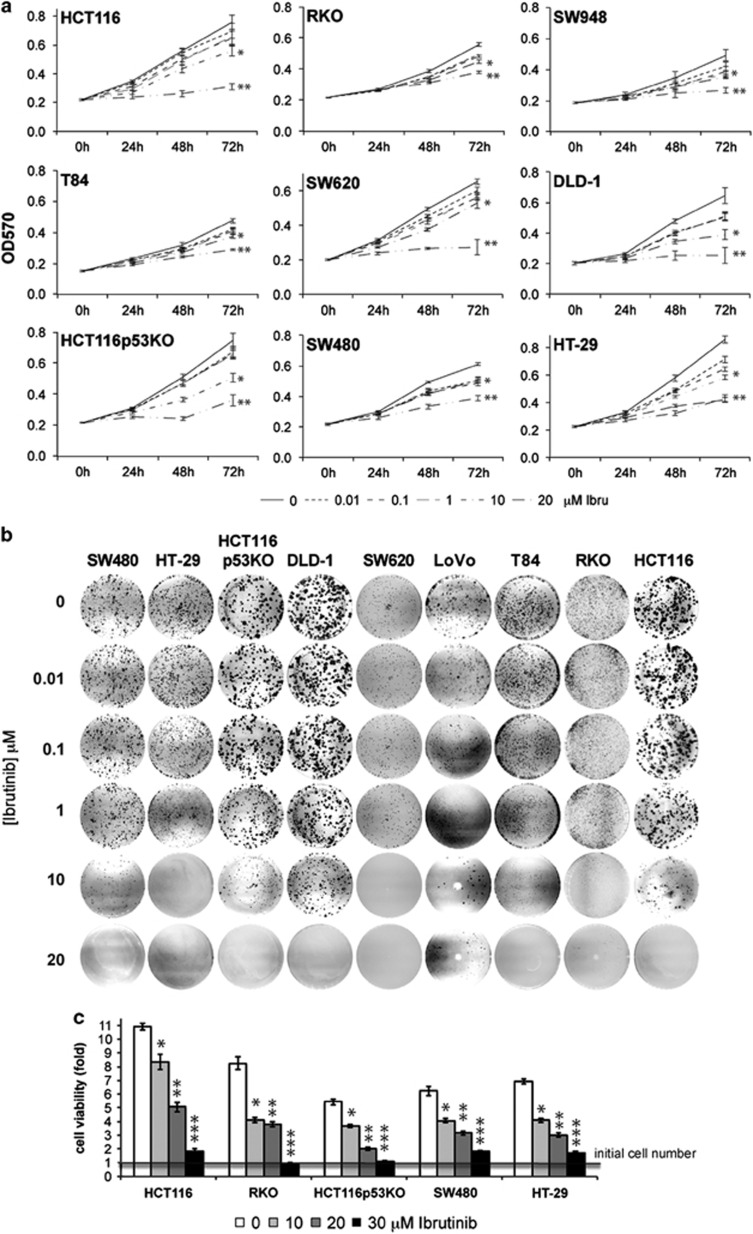
p65BTK inhibition affects growth and survival of colon cancer cells. (a) Time course showing Ibrutinib dose response (0, 0.01, 0.1, 1, 10, 20 μM Ibru) of colon carcinoma cell lines characterized by different genetic background; cell proliferation was determined every 24 h by MTT assay on cells incubated with Ibrutinib at the indicated concentrations; error bars show s.e.m.; data are the average of 3–5 independent experiments. Ibrutinib at 10 and 20 μM significatively decreases cell growth in all cell lines *10 vs 0 μM Ibru P<0.05; **20 vs 0 μM Ibru: P<0.05. (b) Clonogenicity was assessed by seeding cells at low density and incubating them with the indicated doses of Ibrutinib for 10–12 days, at the end of which colonies were stained by crystal violet. (c) Cell viability was assessed after 72 h of treatment with the indicated concentration of Ibrutinib; crystal violet assay was performed to quantify viable cells; data are presented as fold change of the initial cell number obtained from 3 independent experiments; error bars show s.e.m. *10 vs 0 μM Ibru: P<0.05; **20 vs 0 μM Ibru: P<0.05; ***30 vs 0 μM Ibru: P< 0.05.